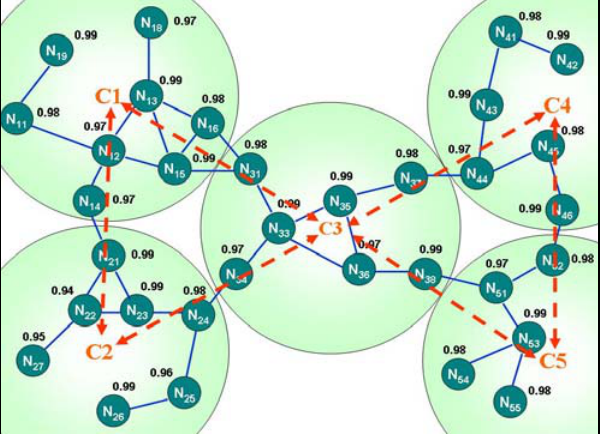
Figure 9. Relationship between local cluster and adjacent